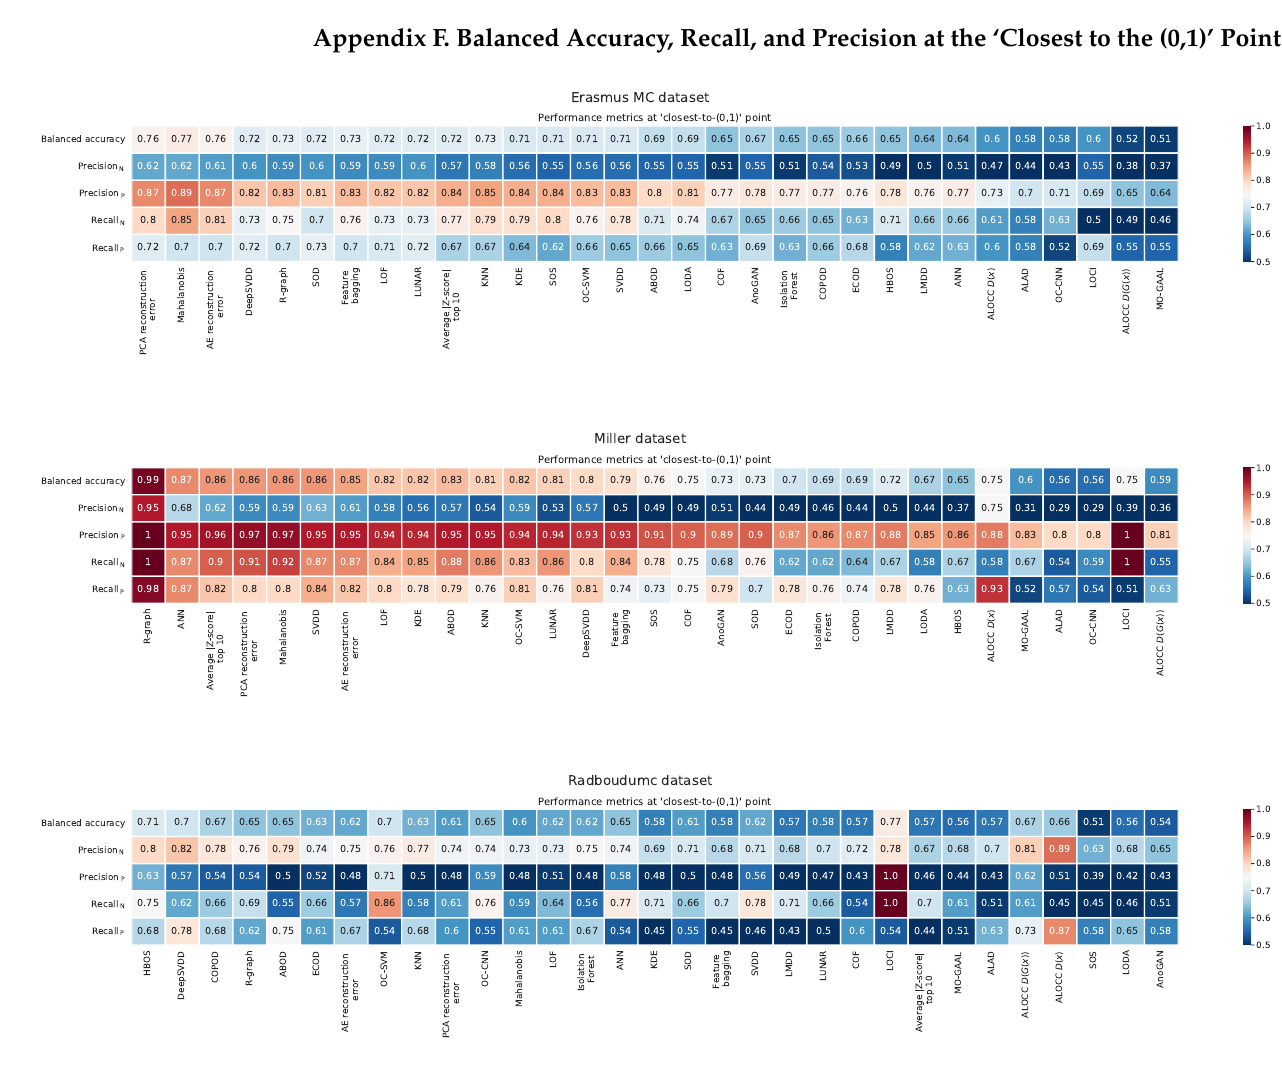
Figure A4. Evaluation metrics at the ‘recall P =0.9’ point for four methods as indicated on the x-axis when 20 PCs are used to transform the dataset.